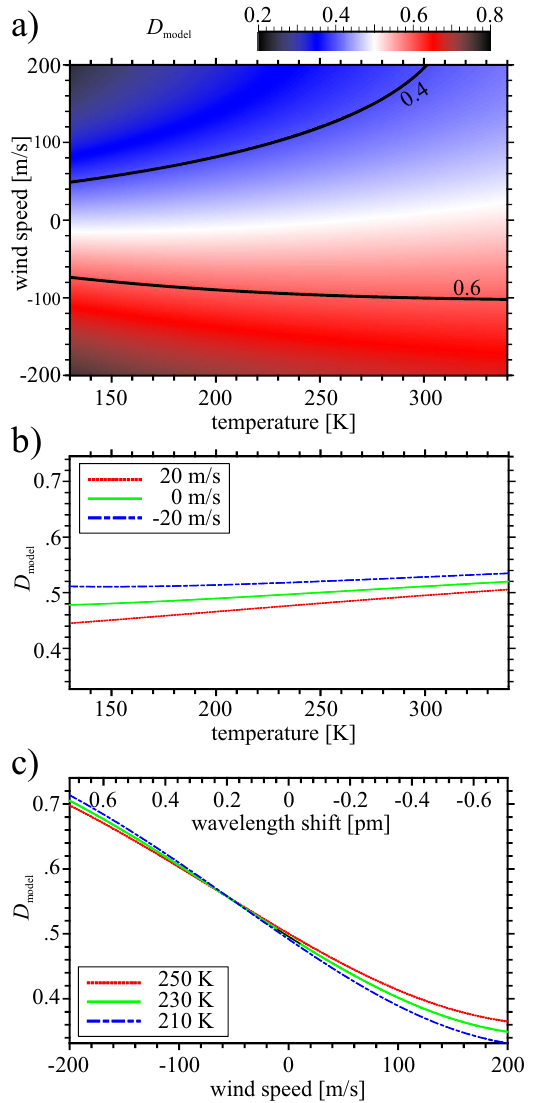
Fig. 5. Modeled Doppler ratio D model for different combina- tions of temperature and wind speed. (a) Color coded atmospheric temperature and wind response with isolines of D model = 0 . 4 and D model = 0 . 6. (b) Temperature response for 0, + 20, − 20m/s wind speed. (c) Wind response for atmospheric temperatures of 210, 230, 250K.